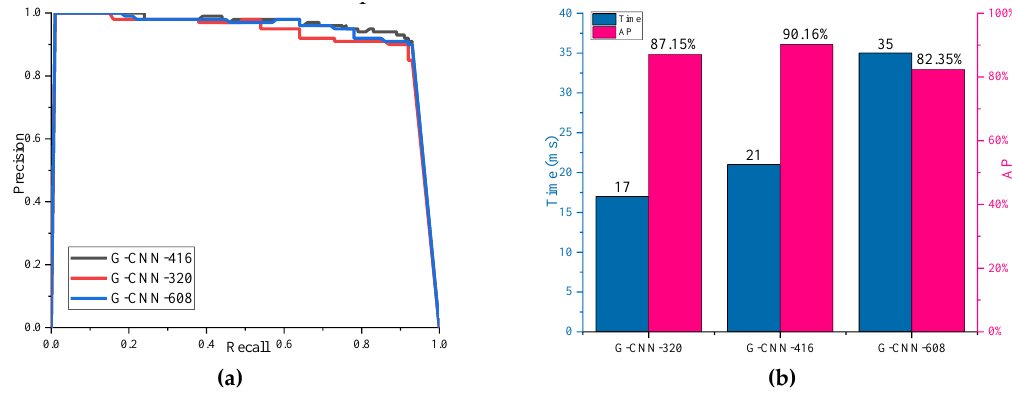
ff erent sized images. ( a ) P-R curve; ( b ) AP and detection Figure 16. Input of different sized images. ( a ) P-R curve; ( b ) AP and detection time. Figure 16. Input of di